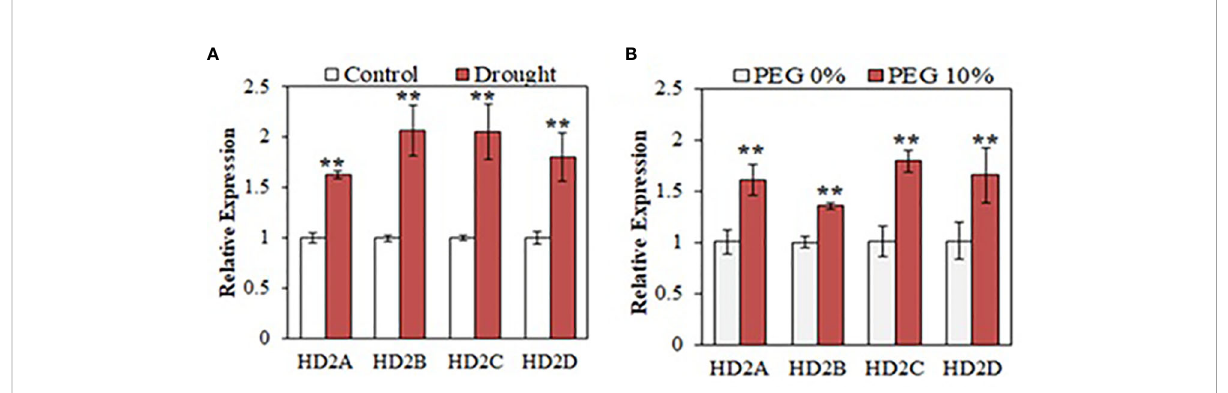
FIGURE 1 HD2 family HDACs respond to drought stress in Arabidopsis. Relative expression of HD2 family genes, HD2A , HD2B , HD2C , and HD2D under drought conditions (A) and PEG-6000-induced osmotic stress (B) in WT Arabidopsis. Data are shown as the expression levels relative to the control condition. Data shown are means ± standard errors (n = 3). The signi fi cance of the differences was determined by Student ’ s t test (**p <